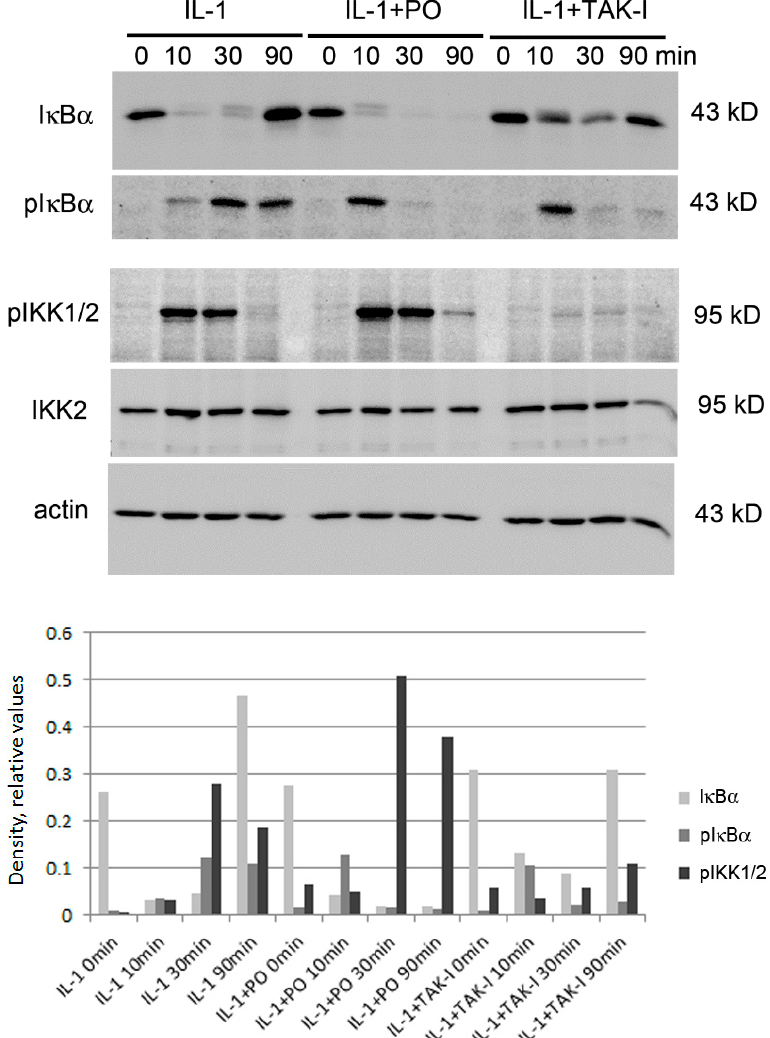
Figure 4. PO a ff ects I κ B α degradation and IKK phosphorylation. Post-confluent HUVEC were Figure 4. PO affects I κ B α degradation and IKK phosphorylation. Post-confluent HUVEC were pre- incubated with 50 μ g/mL of PO for 30 min, then stimulated with 5 ng/mL IL-1 for 90 min and probed pre-incubated with 50 µ g / mL of PO for 30 min, then stimulated with 5 ng / mL IL-1 for 90 min and for I κ B α , phospho-I κ B α , and phospho-IKK1/2; IKK2 and ß-actin served as loading controls, the TAK- probed for I κ B α , phospho-I κ B α , and phospho-IKK1 / 2; IKK2 and ß-actin served as loading controls, the TAK-inhibitor (5 µ M) as control for inhibition. I κ B α / pI κ B α and IKK2 / pIKKs / actin were analyzed on separate gels. A densitometric quantification is shown